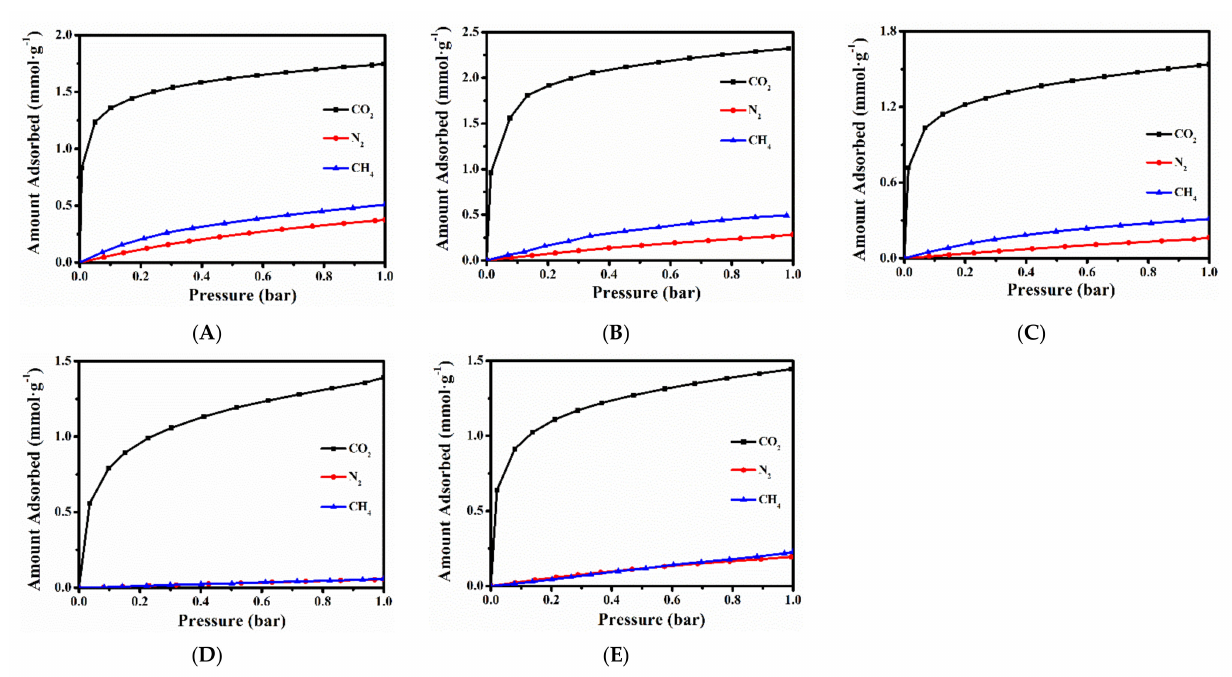
Figure 5. Adsorbed isotherms of (Na, K)–CP ( A ), Li–6–CP ( B ), Cs–6–CP ( C ), Ca–4–CP ( D ), and Sr–8–CP ( E ) using CO 2 , N 2 and CH 4 as adsorbate at 273